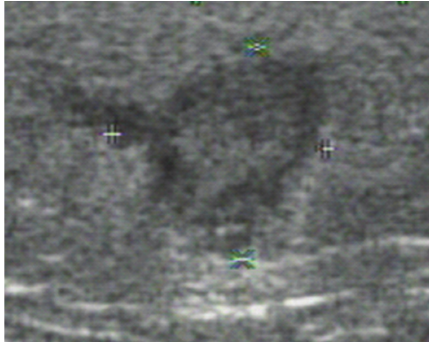
Figure 1: A subcutaneous nodule was detected by sonogram. Size: 10 . 3 × 10 mm. Depth: 11.3mm.